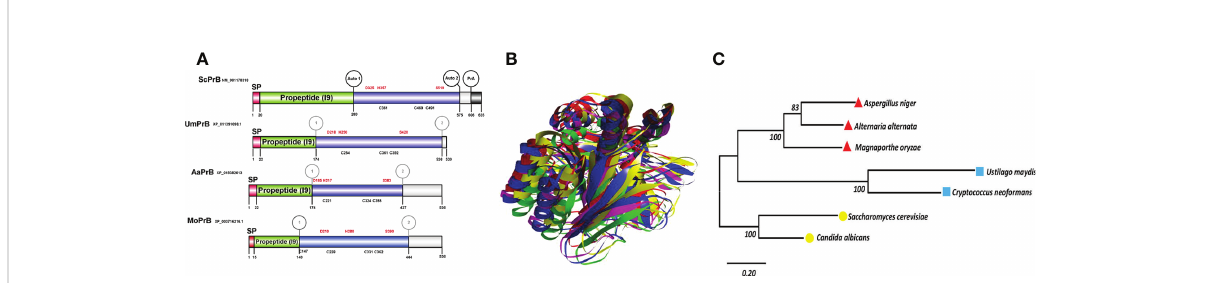
FIGURE 5 Serine vacuolar endoproteases PrBs are conserved in pathogenic and nonpathogenic fungi. (A) The characteristic domains of vacuolar proteases of the S8 family are illustrated, including the DHS catalytic triad of serine proteases, the probable maturation sites, and the I9 inhibitor domain of the propeptide (predicted in the Expasy server). Proteases such as ScPrB are apparently synthesized as zymogens, which are inactive until propeptides are removed in the vacuole. The cysteines in the protein are also shown. The circles in the S. cerevisiae protease designate the regions where autocatalysis and PrA processing are conducted. In the rest of the proteases, the circles denote regions of theoretical maturation. The alignment of sequences was performed with Clustal X and the drawing with BioRender.com (accessed in April 2022). (B) Tertiary structure of fungal PrBs. The overlap is represented by utilizing the best model of PrB of S. cerevisiae (green) and of the three fungal phytopathogens herein studied: U. maydis (blue), M. oryzae (fuchsia), and A alternata (yellow). (C) Phylogenetic analysis of the PrB of different organisms. Carried out in the MEGA6 program with the maximum likelihood method, the WAG+G model, and 100 bootstrap replicates. The phylogenetic tree is drawn to scale, with the length of the branches depicting the corresponding evolutionary distances. Fungi that are grouped together in the same clade are portrayed with red, blue, and yellow